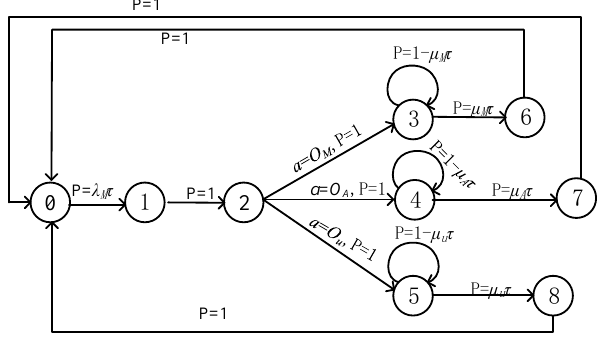
Figure 4. Transfer probability map.